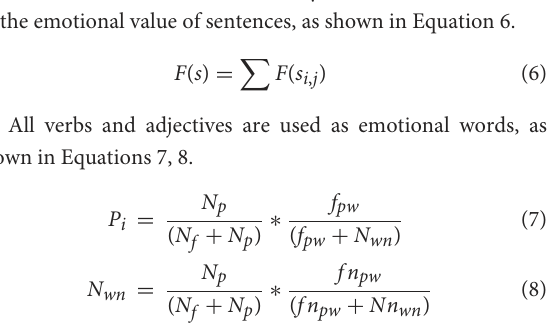
are calculated, and the text is judged as the emotion category corresponding to the highest score, as shown in Equation